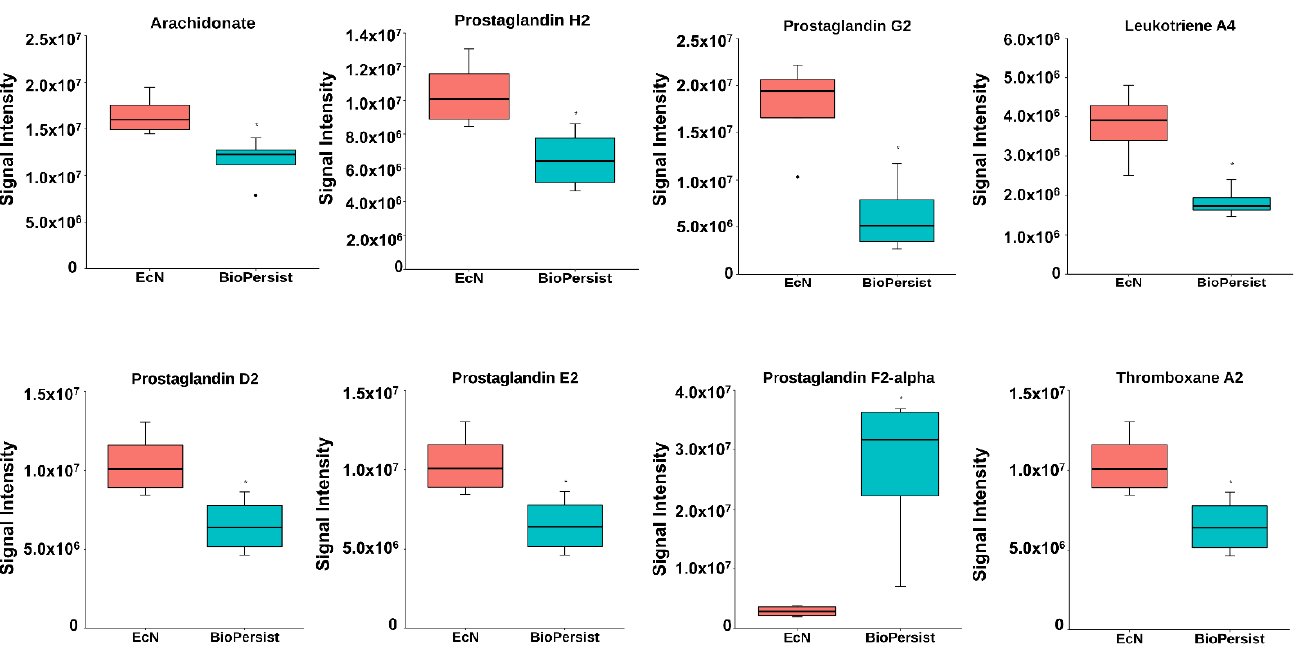
Figure 3. BioPersist reduces the production of pro-inflammatory prostaglandins. Individual metabolites involved in the prostaglandin biosynthesis pathway. n = 4 per group. * p < 0.05.